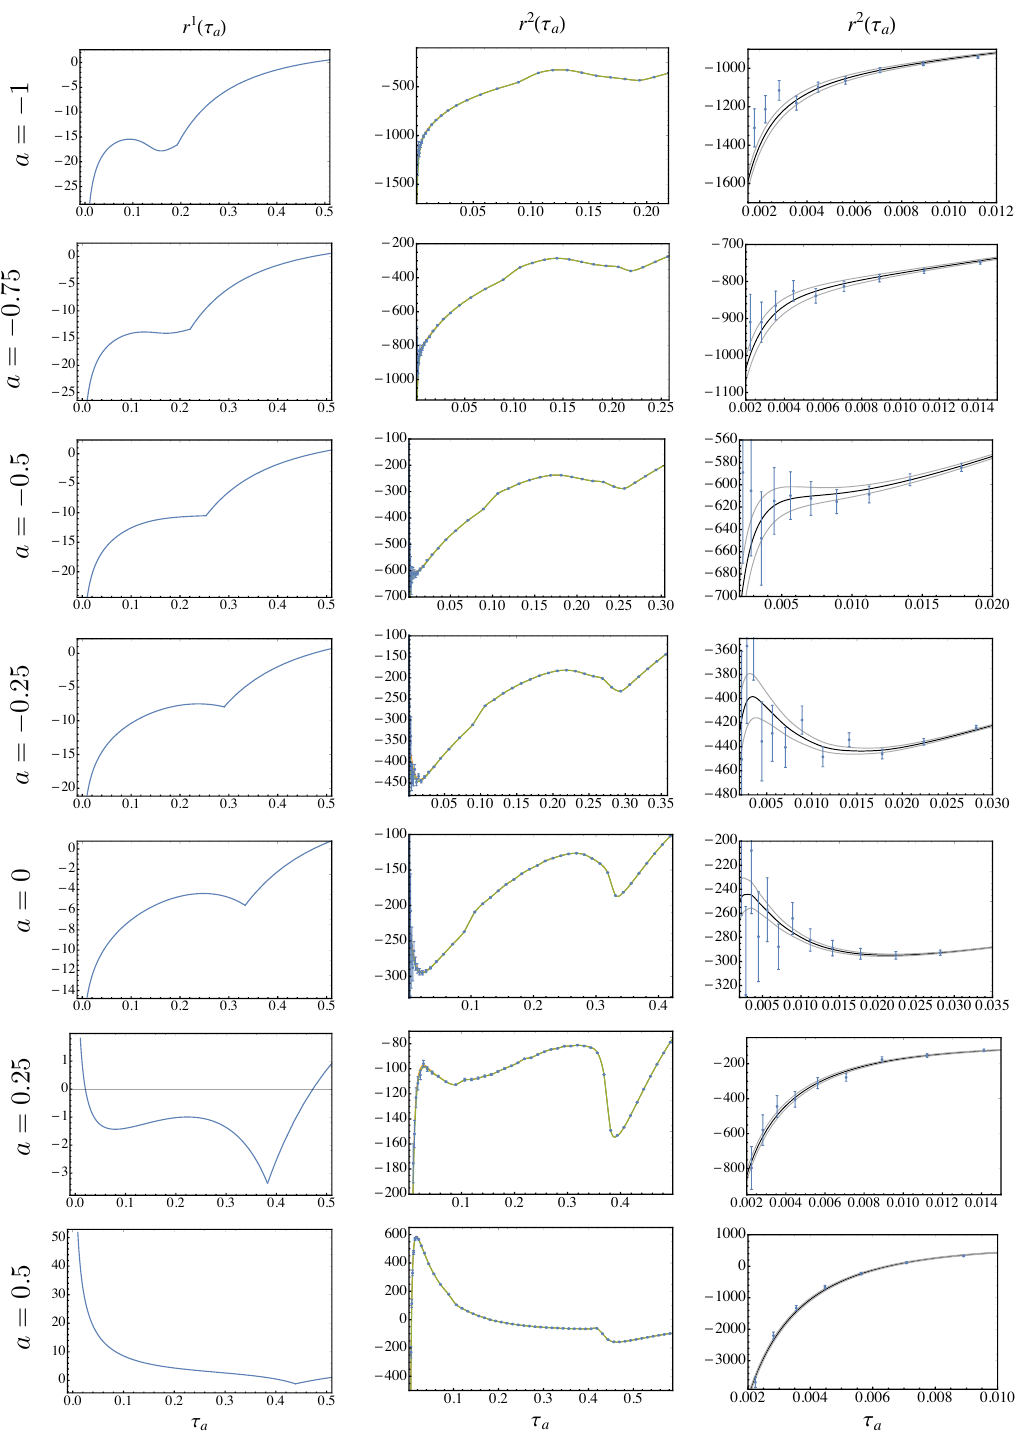
( (cid:11) 2 ) remainder functions across s O